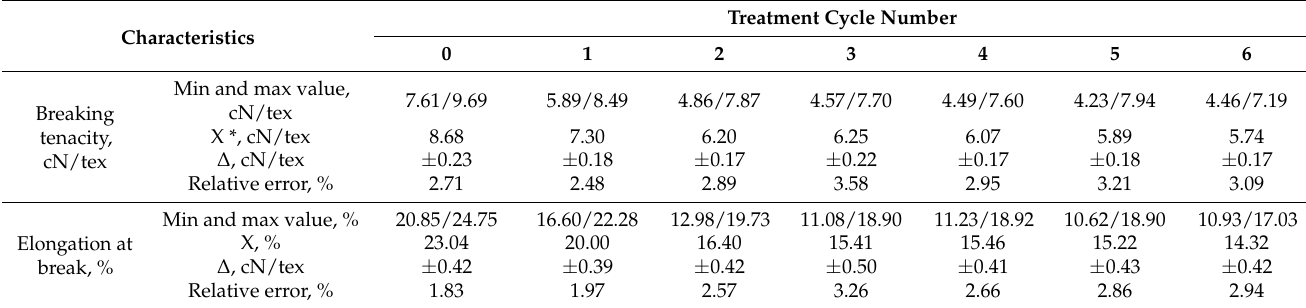
Table 3. Tensile characteristics of investigated PAN fibers.